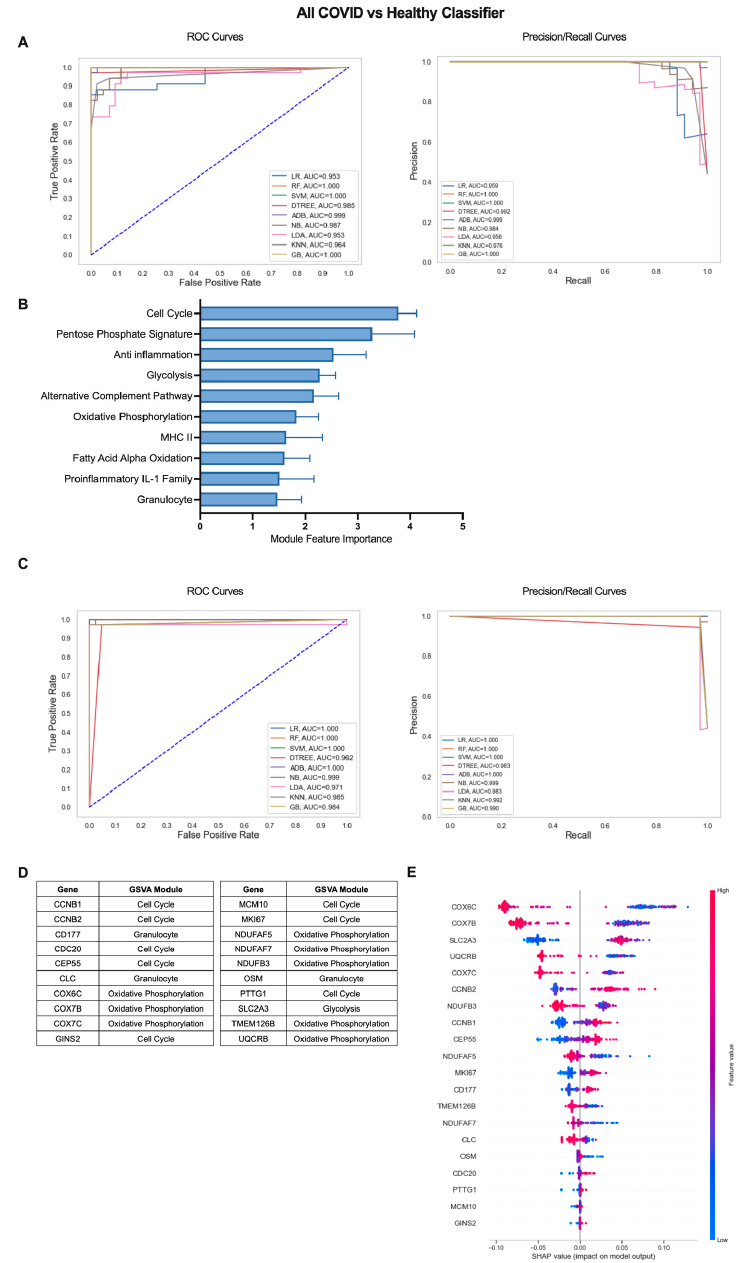
Figure 2. Iterative ML COVID-19 patient vs. healthy individual classifier results. ( A ) Representative ROC and PR curves from the first ML pipeline iteration for the all COVID-19 patients vs. healthy control classifier. ( B ) Bar graph of feature importance values for the top 10 gene modules resulting from the second ML pipeline iteration. ( C ) Representative ROC and PR curves from the third ML pipeline iteration for the all COVID-19 patients vs. healthy control classifier. ( D ) Top 20 gene features resulting from the third ML pipeline iteration. ( E ) SHAP summary plot depicting the magnitude and directionality of relationships between the top 20 gene features and COVID-19 classification.